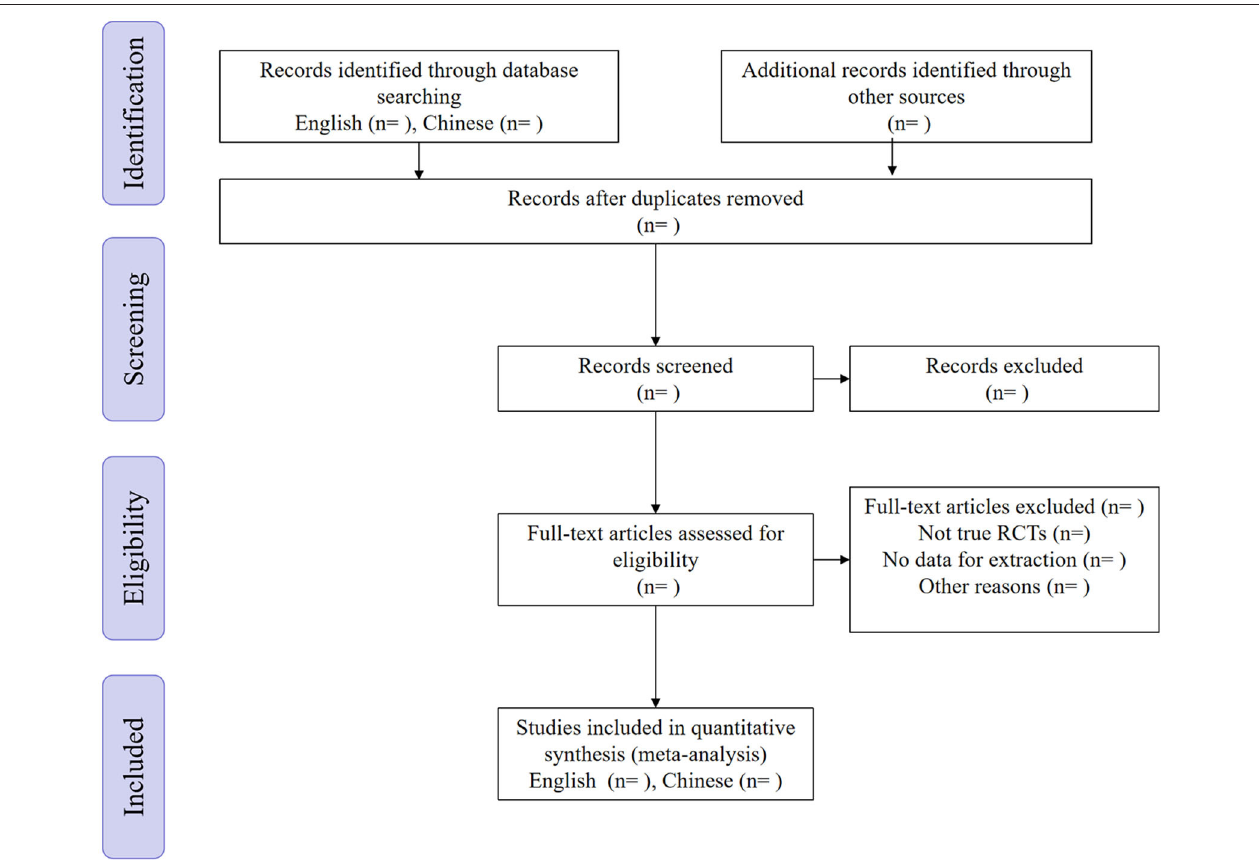
FIGURE 1 | Flow diagram of the study selection process. RCT, randomized controlled trial.